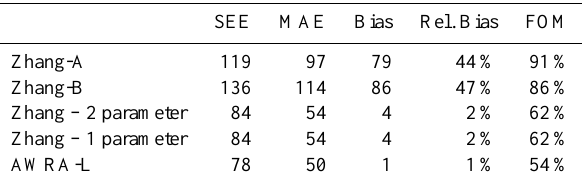
Table 1. Performance indicators of the original Zhang et al. (2001) models (Zhang-A and Zhang-B; see text for explanation), the Zhang model with one and two calibrated parameters, respectively, and the AWRA-L with prior parameter estimates. Al metrics relate to the agreement between modelled and observed mean annual streamflow ( Q , mm per year) for all catchments ( N =278). SEE=standard error of estimate, MAE=mean absolute error, and Bias=mean bias (all in mm yr − 1 ) ; Rel. Bias=mean of absolute values of percentage bias and FOM=fraction of values overestimated by model (in %).